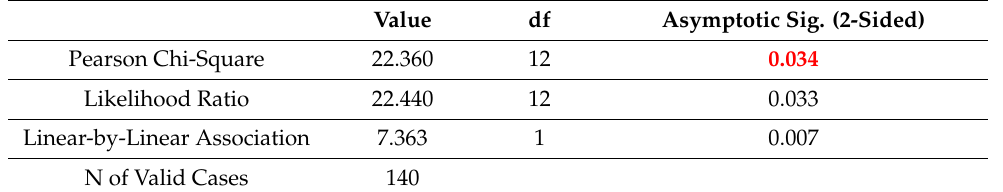
Table 13. Results for Chi-Square bivariate test.